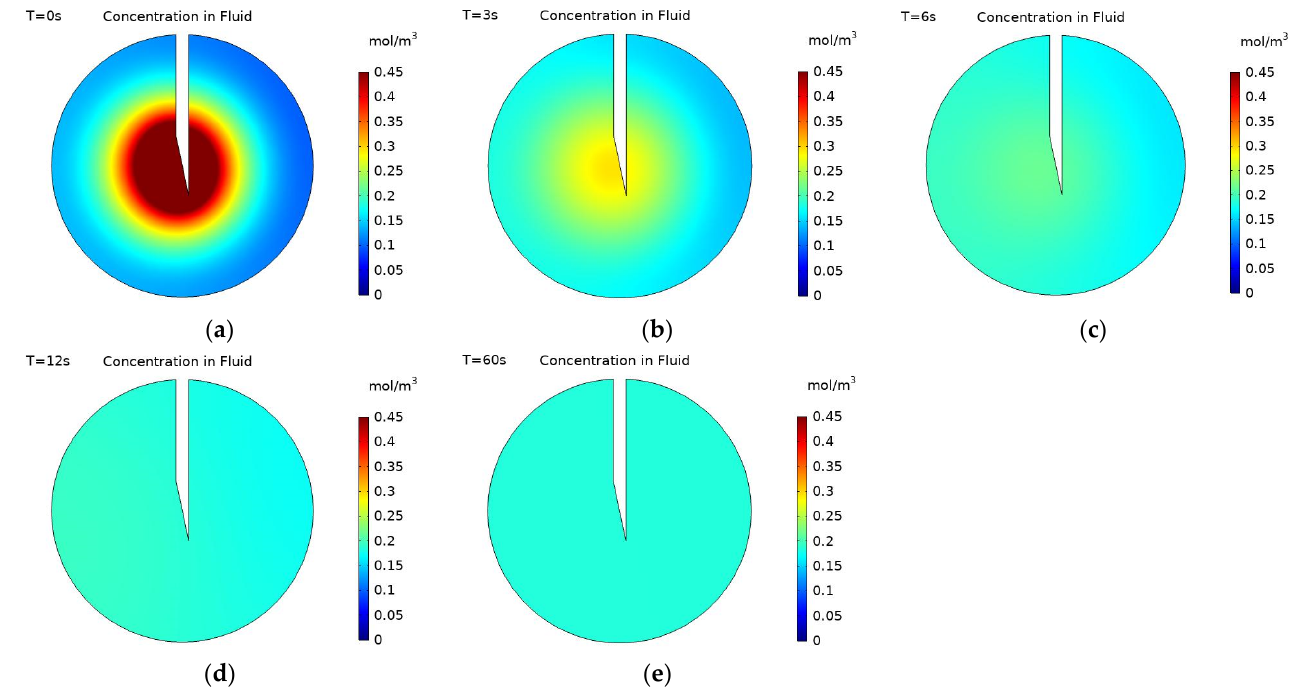
Figure 6. Concentration contours of charged nanoparticles ( − 20 mV) within the fluid at; ( a ) end of injection, and ( b ) 3 s, ( c ) 6 s, ( d ) 12 s, and ( e ) 60 s post-injection.